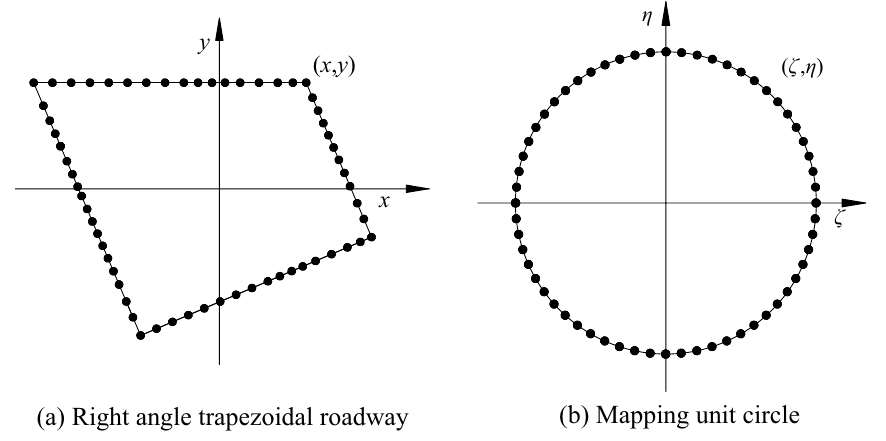
Figure 6. Roadway model to ζ mapping of plane unit circle.